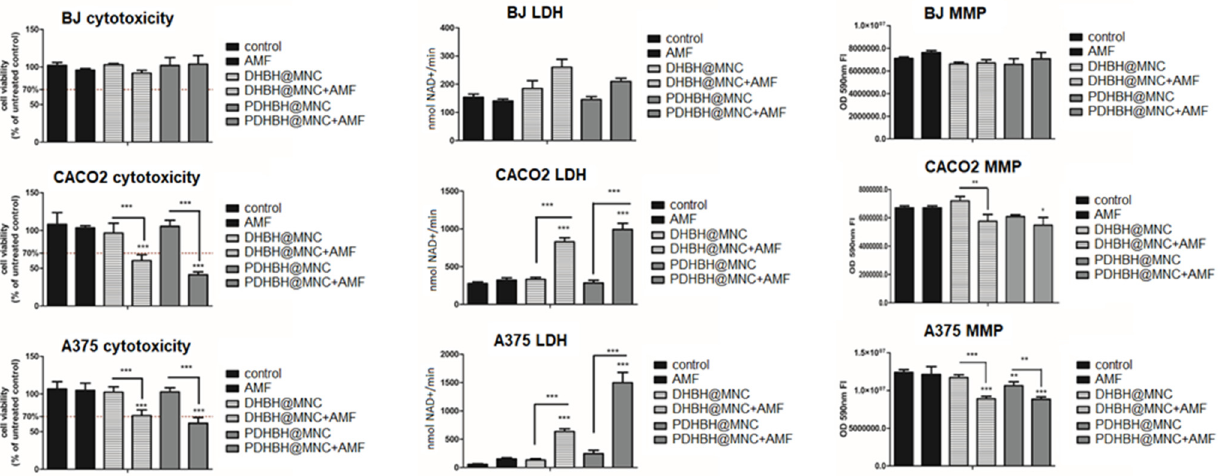
Figure 9. Cytotoxicity of cells (fibroblasts (BJ), upper panels; colon adenocarcinoma (CACO2), middle panel; and melanoma (A375), lower panel). Cells were exposed to AMF (frequency of 355Hz, amplitude of 40kA/m, time 40 min) and were incubated with either DHBH@MNC or PDHBH@MNC (50 µg/mL) with and without MH treatment. Cell cytotoxicity assay results are presented as % of untreated controls. LDH measurements are presented as nmolNAD+/min. Mitochondrial membrane potential alterations are measured by MITO ID assay; results are presented as fluorescence OD 590nm readings (right panels). Each bar represents mean ± standard deviation (n = 3); * = p < 0.05, ** = p < 0.001, *** = p < 0.0001, control versus treated group (cells exposed to AMF, incubated with MNC with and without MH exposure) for each cell line.